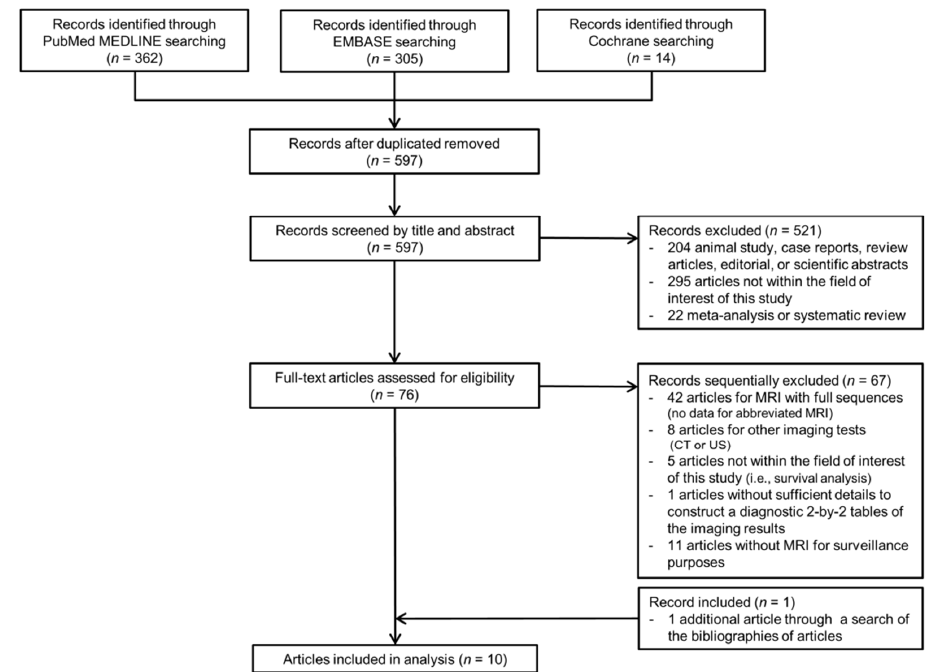
Figure 1. PRISMA diagram of the eligible article selection. CT, computed tomography; US, ultrasonography; MRI, magnetic resonance imaging.